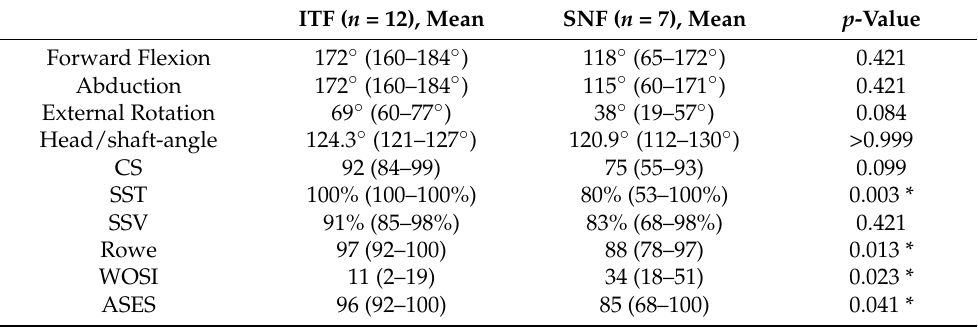
Table 3. Results of the functional outcome during follow-up: patients in the ITF group showed greater values than patients in the SNF group, with some significant differences (*). Mean column shows mean values, upper and lower limit shows upper and lower CI (95%); CS = Constant Score (corrected for age and gender); SST = Simple Shoulder Test; SSV = Subjective Shoulder Value; WOSI = Western Ontario Shoulder Instability Index; ASES = American Shoulder and Elbow Surgeons Standardized Shoulder Assessment